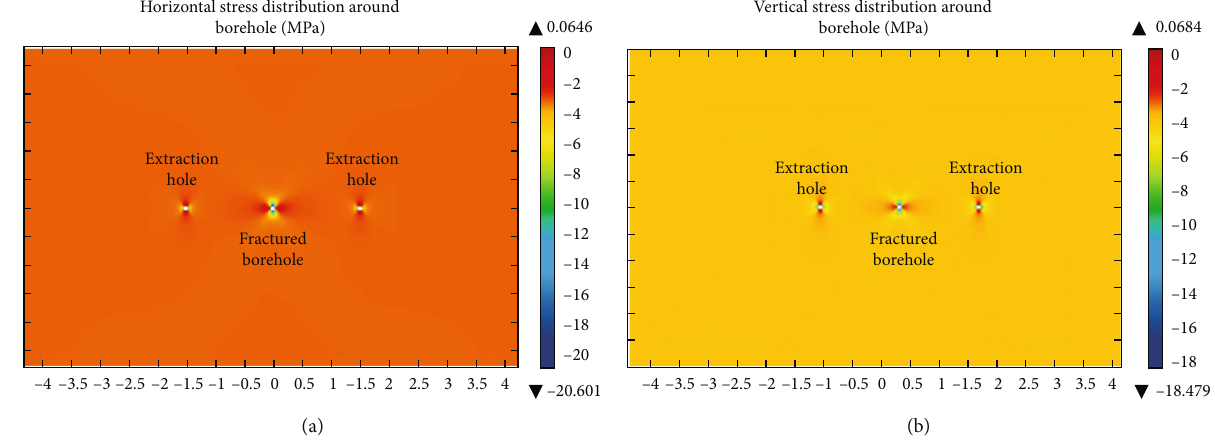
Figure 4: Stress distribution around borehole after liquid carbon dioxide